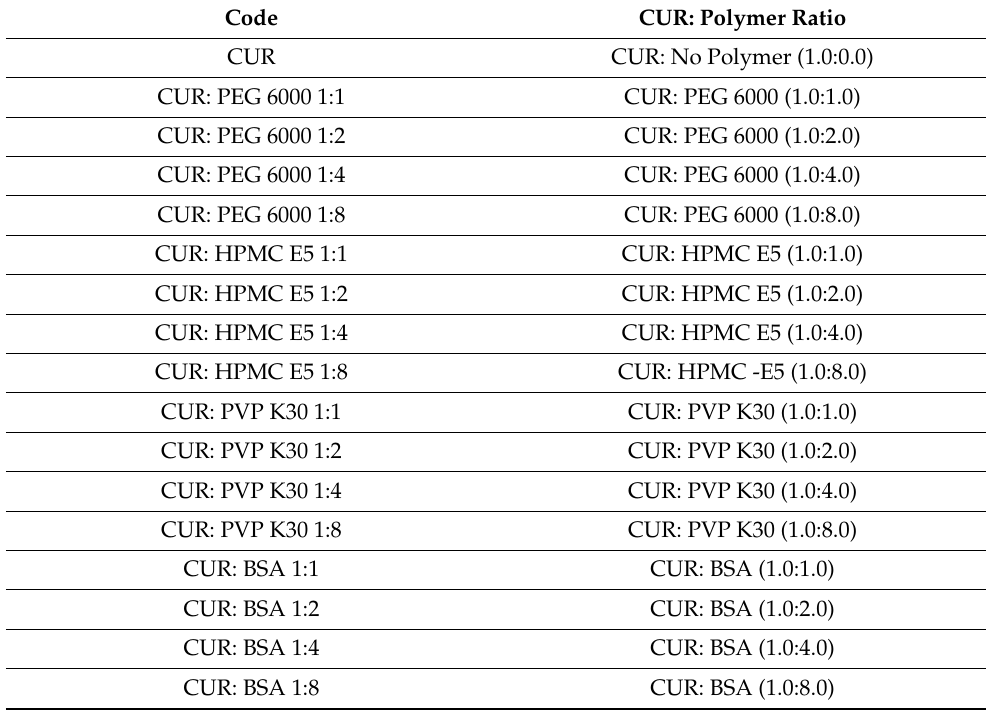
Table 1. Curcumin and carriers (PEG 6000, HPMC E5, PVP K30, and BSA) at different ratios. Code CUR: Polymer